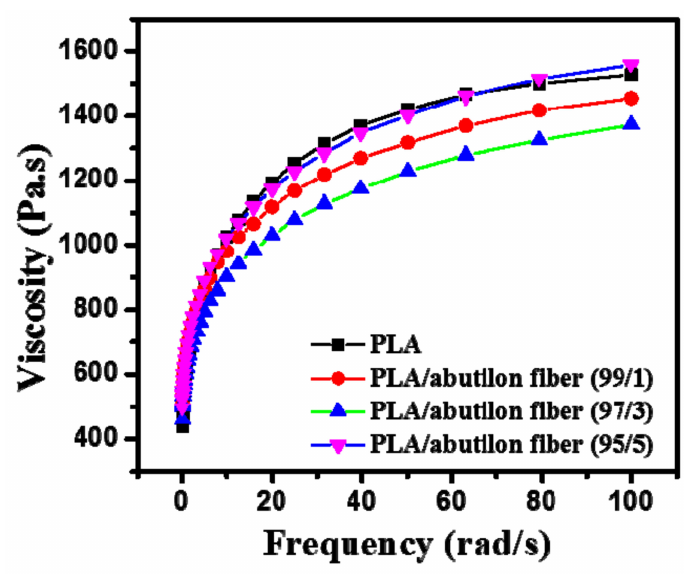
Figure 11. The viscosity of (PLA / abutilon fiber) composites.